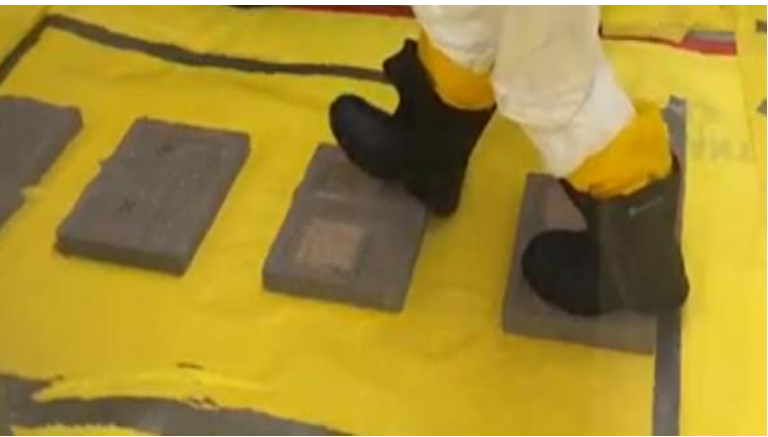
Figure 7. Straight-line Walking